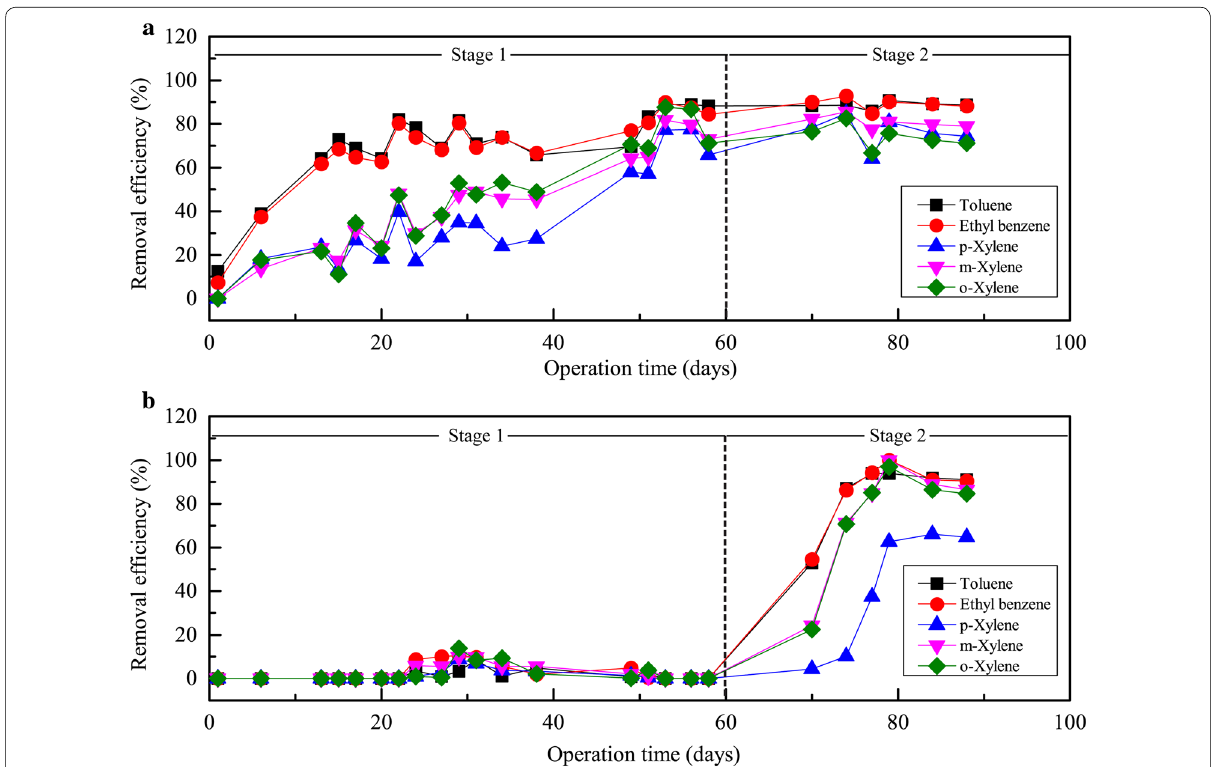
Fig. 2 Removal efficiencies of the five aromatic compounds in BTF1 ( a ) and BTF2 ( b